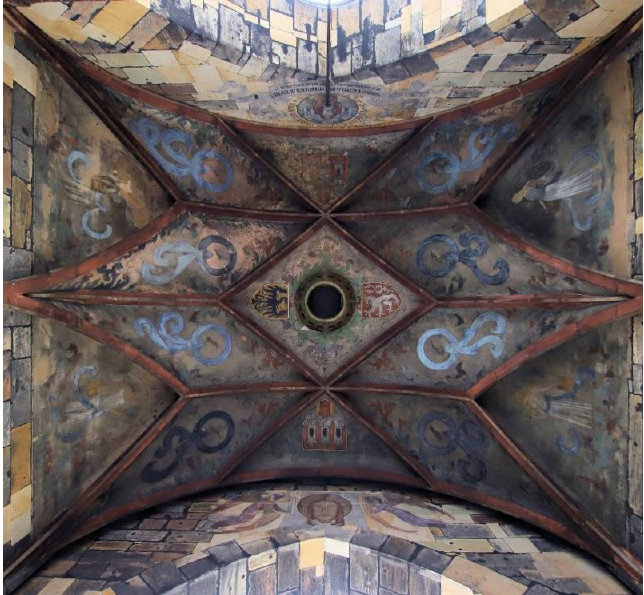
Figure 8. Prague, Old Town Bridge Tower, paintings from the late 1380s or 1390s. Photo by František Záruba, the author’s own work.